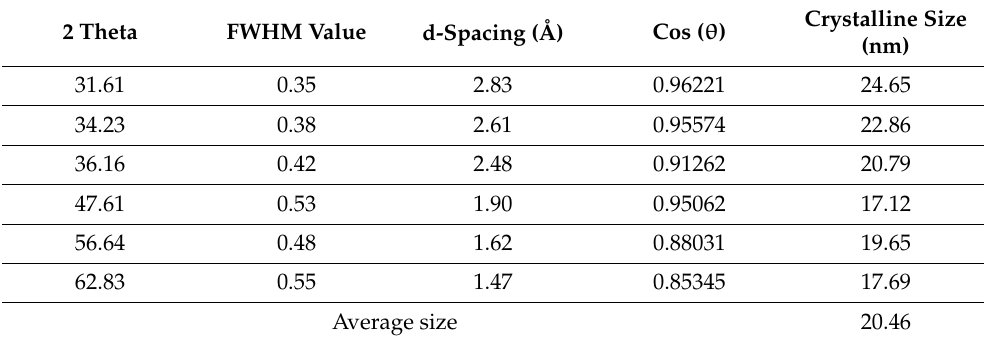
Table 2. The structure and geometric parameters of the ZnO